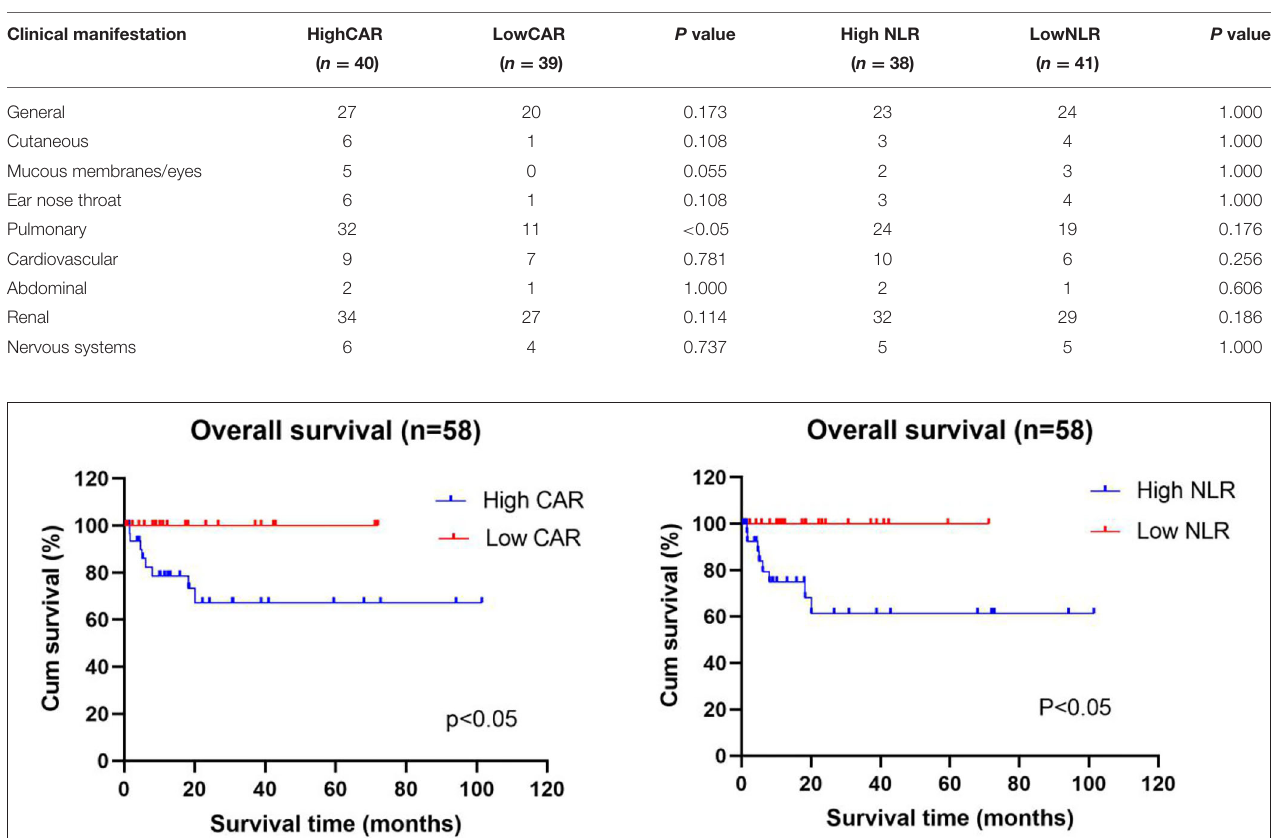
TABLE 4 | Clinical manifestation of high CAR and low CAR, high NLR and low NLR AAV patients.